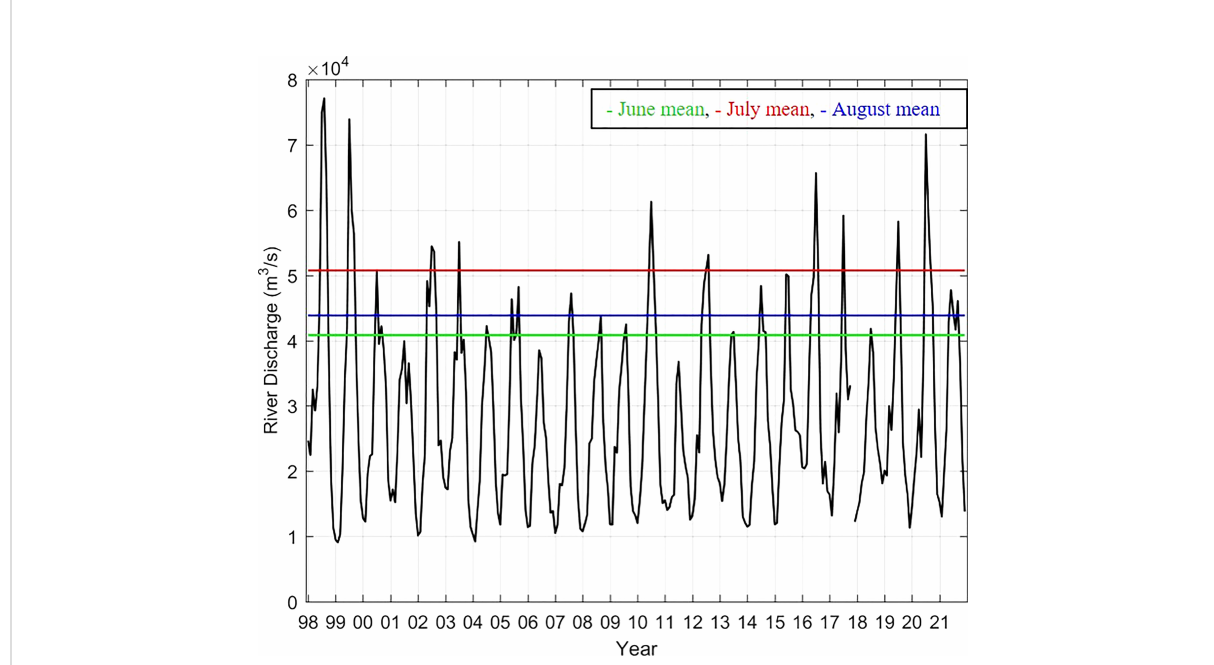
FIGURE 2 Monthly Changjiang River Discharge (CRD) from 1998 to 2021 (obtained by averaged daily